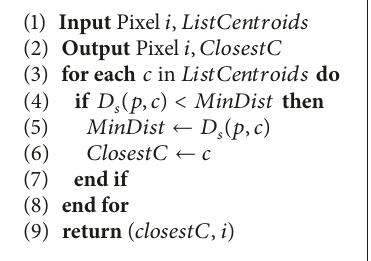
Algorithm 1: Map segmentation function.